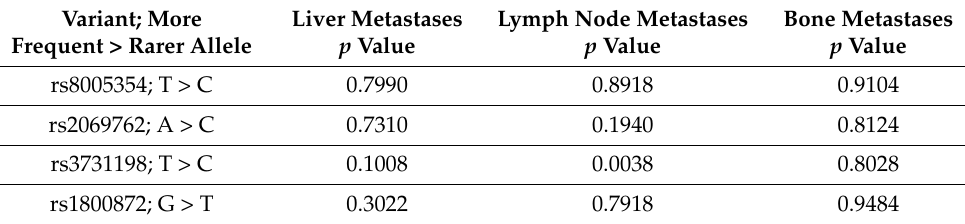
Table 6. Correlation between the distant metastasis and the number of rarer